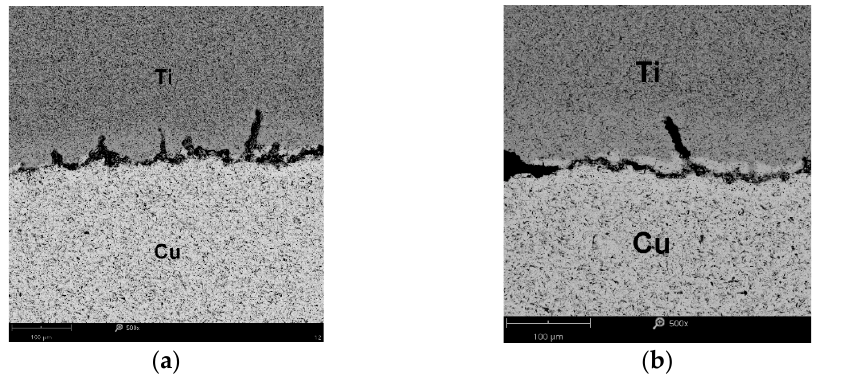
Figure 14. The contact zone of the titanium and copper layer in the bimetal after annealing at T = 900 °C and during: ( a ) t = 60 min, ( b ) t = 90 min.